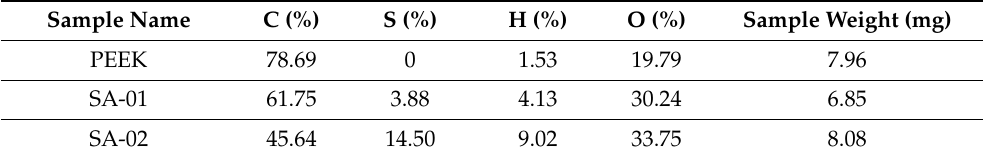
Table 2. The elemental composition of PEEK and two samples of sulfonated PEEK with different degrees of sulfonation obtained from an EDS